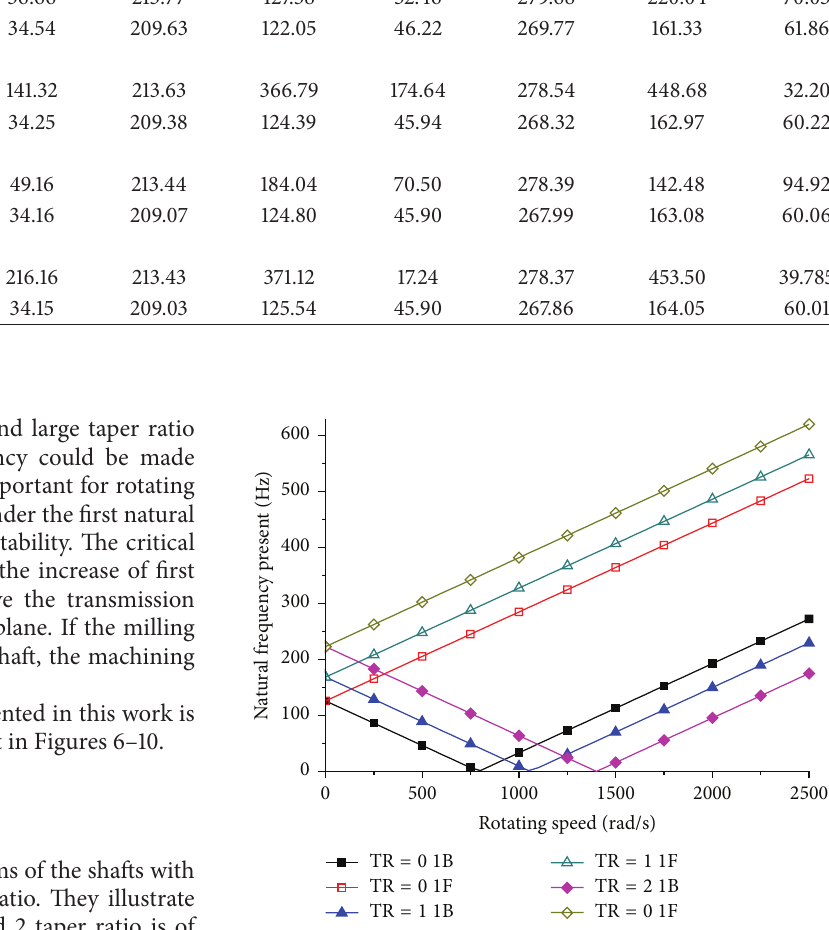
Figure 12: Campbell diagrams of the shaft with 𝜃 = 20 ∘